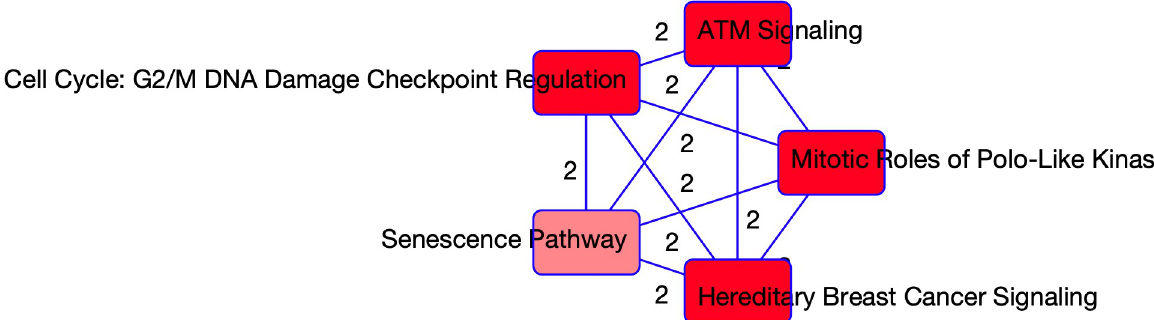
Fig 2. Overlapping networks associated with COVID-19. Visual of the overlapping networks enriched in COVID-19 as determined from the RNAseq data. The nodes represent the networks and the edges represent the overlapping genes between the networks. The edge labels give the number of overlapping molecules between the networks.